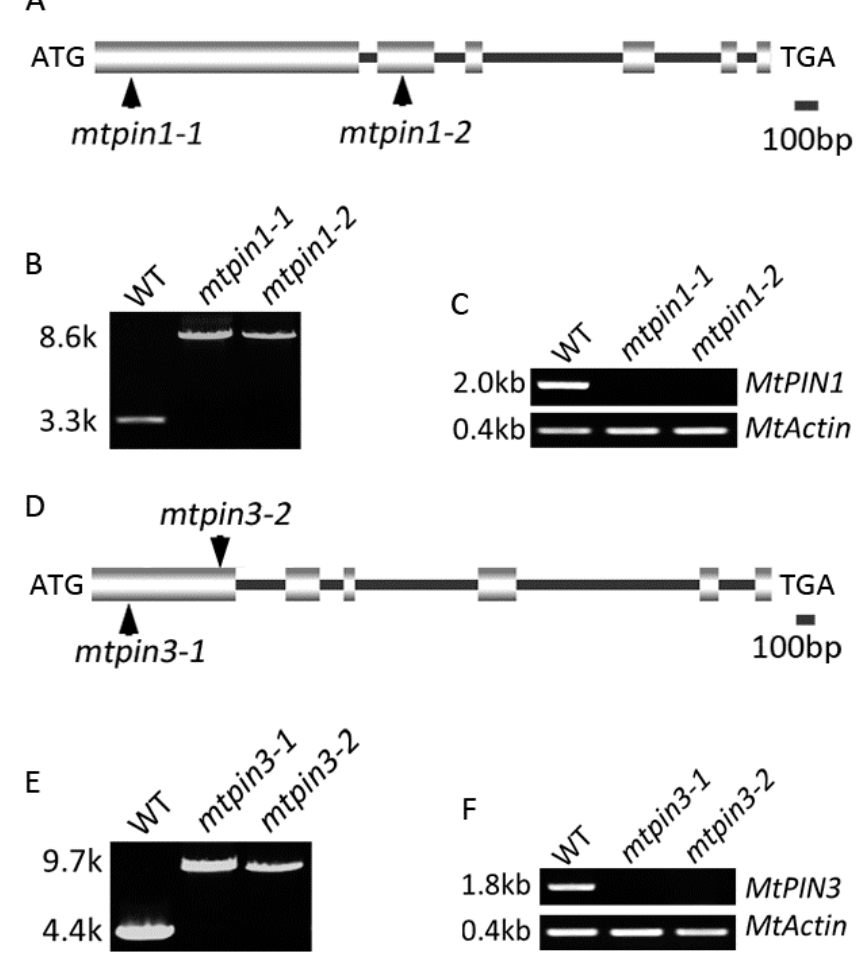
Figure 1. Molecular characterization of MtPIN1 and MtPIN3 in M. truncatula . ( A , D ) Schematic representation of the gene structure of MtPIN1 and MtPIN3 . The position of the ATG start and TGA stop codon are shown. Vertical arrows mark the Tnt1 insertion site in mtpin1 and mtpin3 . ( B , E ) PCR